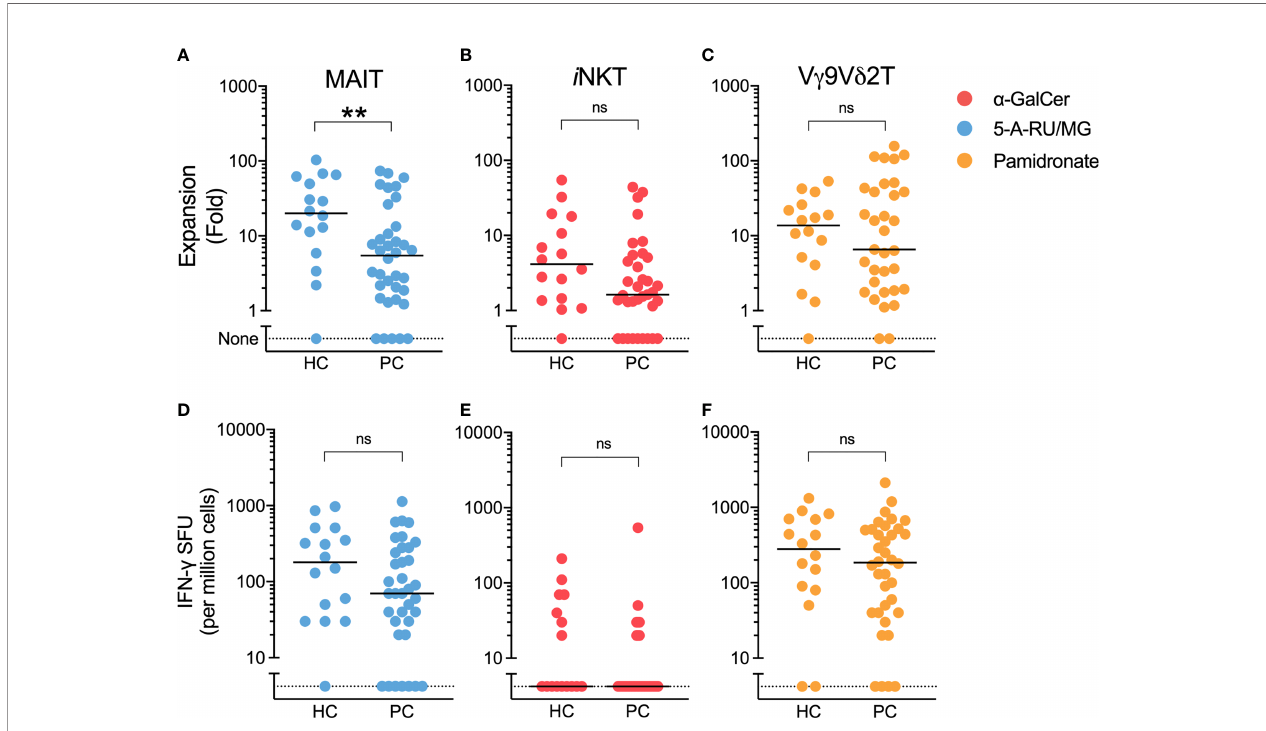
FIGURE 2 | 5-A-RU/MG stimulated MAIT-cell proliferation, but not IFN- g SFU, is impaired in men with prostate cancer. The proliferation of MAIT (A) , NKT (B) and V g 9V d 2T (C) cells was measured at the end of 7 days in culture with stimuli as indicated and expressed as a fold change to media control. IFN- g spot forming units (SFUs) determined by ELISpot assay are demonstrated for PBMCs cultured with 5-A-RU/MG (D) , a -GalCer (E) and pamidronate (F) . **P < 0.01, Mann-Whitney test. N = 20 healthy controls, 36 men with prostate cancer. ns, no signi fi